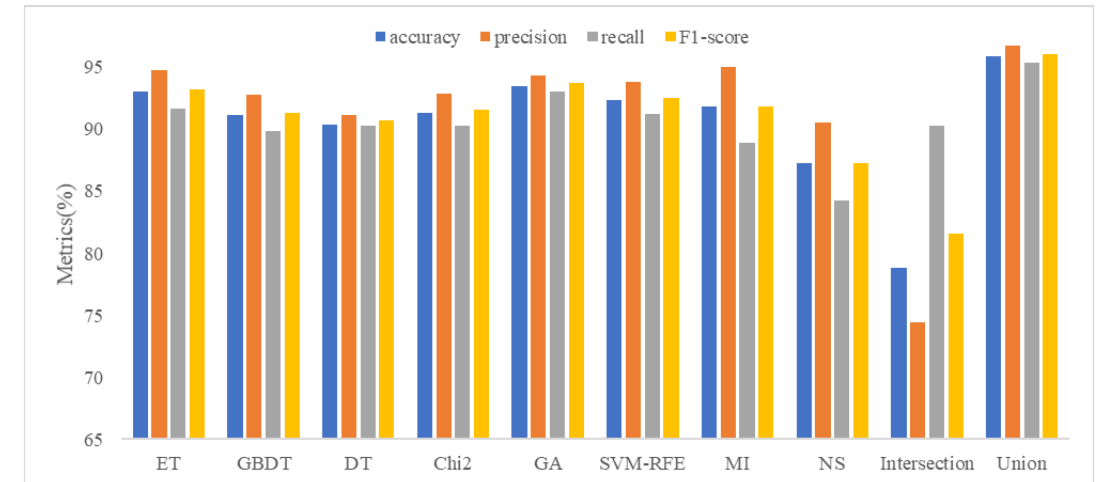
Figure 4. Feature selection results comparison on our dataset. Table 9. Evaluation metrics for different feature selection methods on ours and OmniDroid.